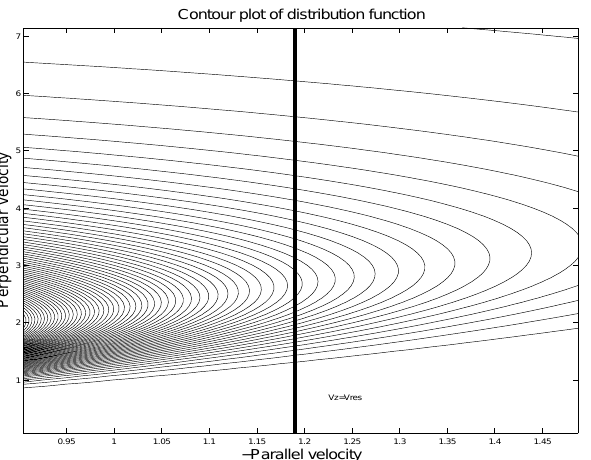
Fig. 2. Dependence of particle energy on pitch angle for electrons cyclotron resonant with Omega